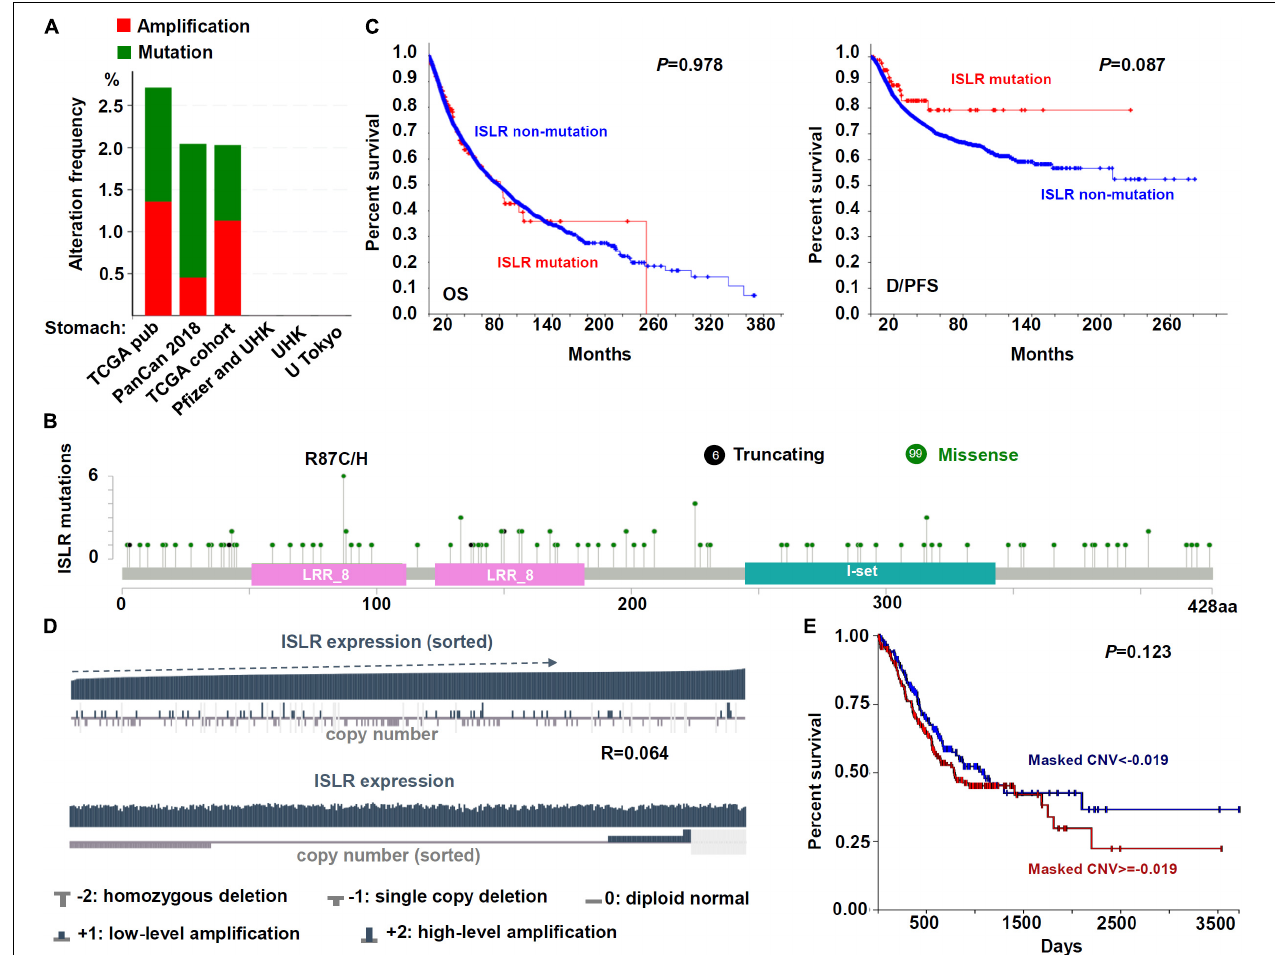
FIGURE 3 | Mutation and CNV analyses of the ISLR gene. (A) The alteration frequency of the ISLR gene for the cases in several studies as analyzed through cBioPortal. (B) The mutation site profile of the ISLR gene is shown. (C) OS and D/PFS analyses according to the mutation status of the ISLR gene were performed. (D) Correlation between copy number variation and expression of ISLR . (E) OS analysis according to the CNV status of the ISLR gene was